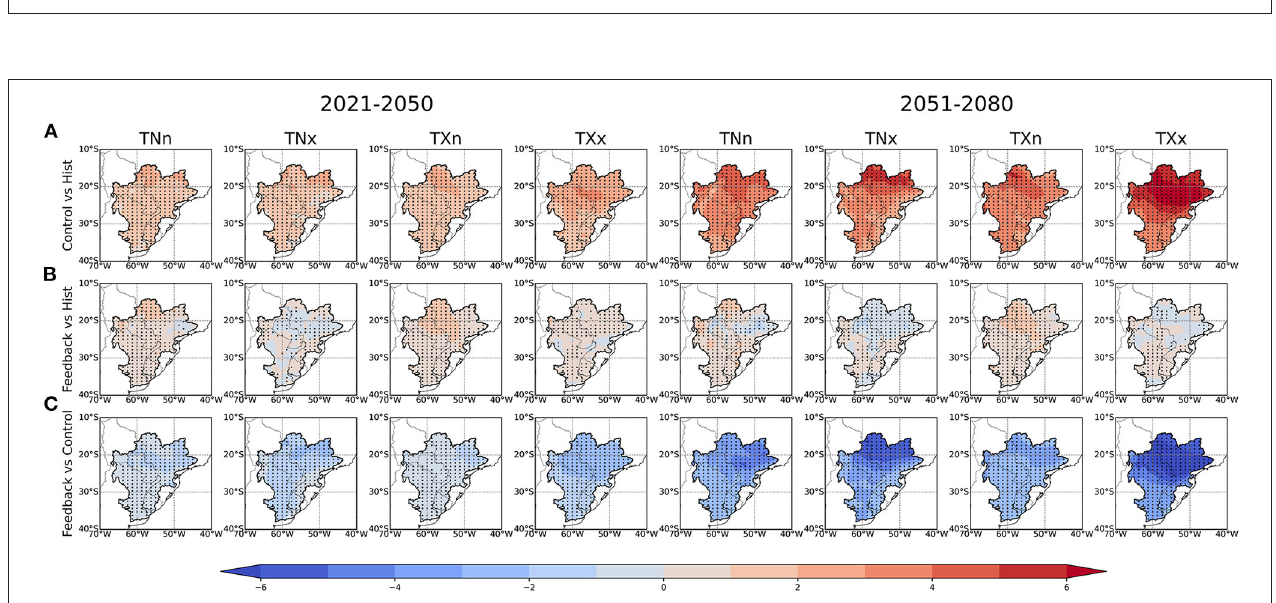
FIGURE 4 | Annual projected changes in temperature extreme indices: TNn (coldest daily Tmin), TNx (warmest daily Tmin), TXn (coldest daily Tmax) and TXx (warmest daily Tmax) ( ◦ C) derived from the three-member ensemble mean values for two future 30-year periods (2021–2050 and 2051–2080) and the mean values over the historical period (1980–2010): (A) Projected changes under the RCP8.5 emission scenario (control simulations) relative to historical, (B) projected changes for the geoengineering simulations combined with the RCP8.5 pathway (feedback simulations) relative to historical, and (C) the difference between (A,B) . Stippling indicates robust changes according to the definition of robustness adopted in this study [see section projections in the text for further details].